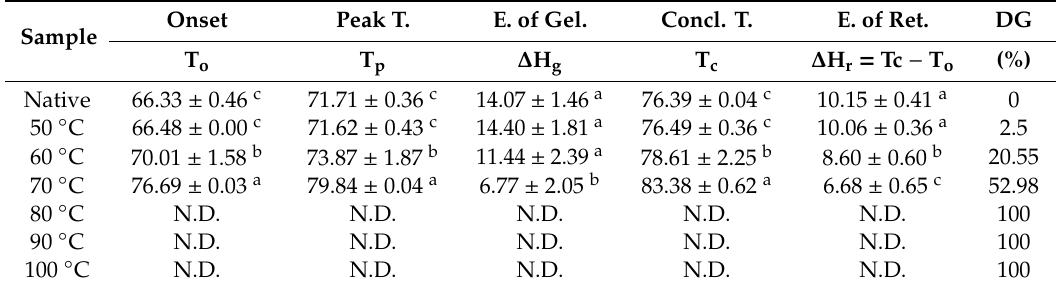
Table 1. Thermal properties of controlled gelatinized mung bean starch.